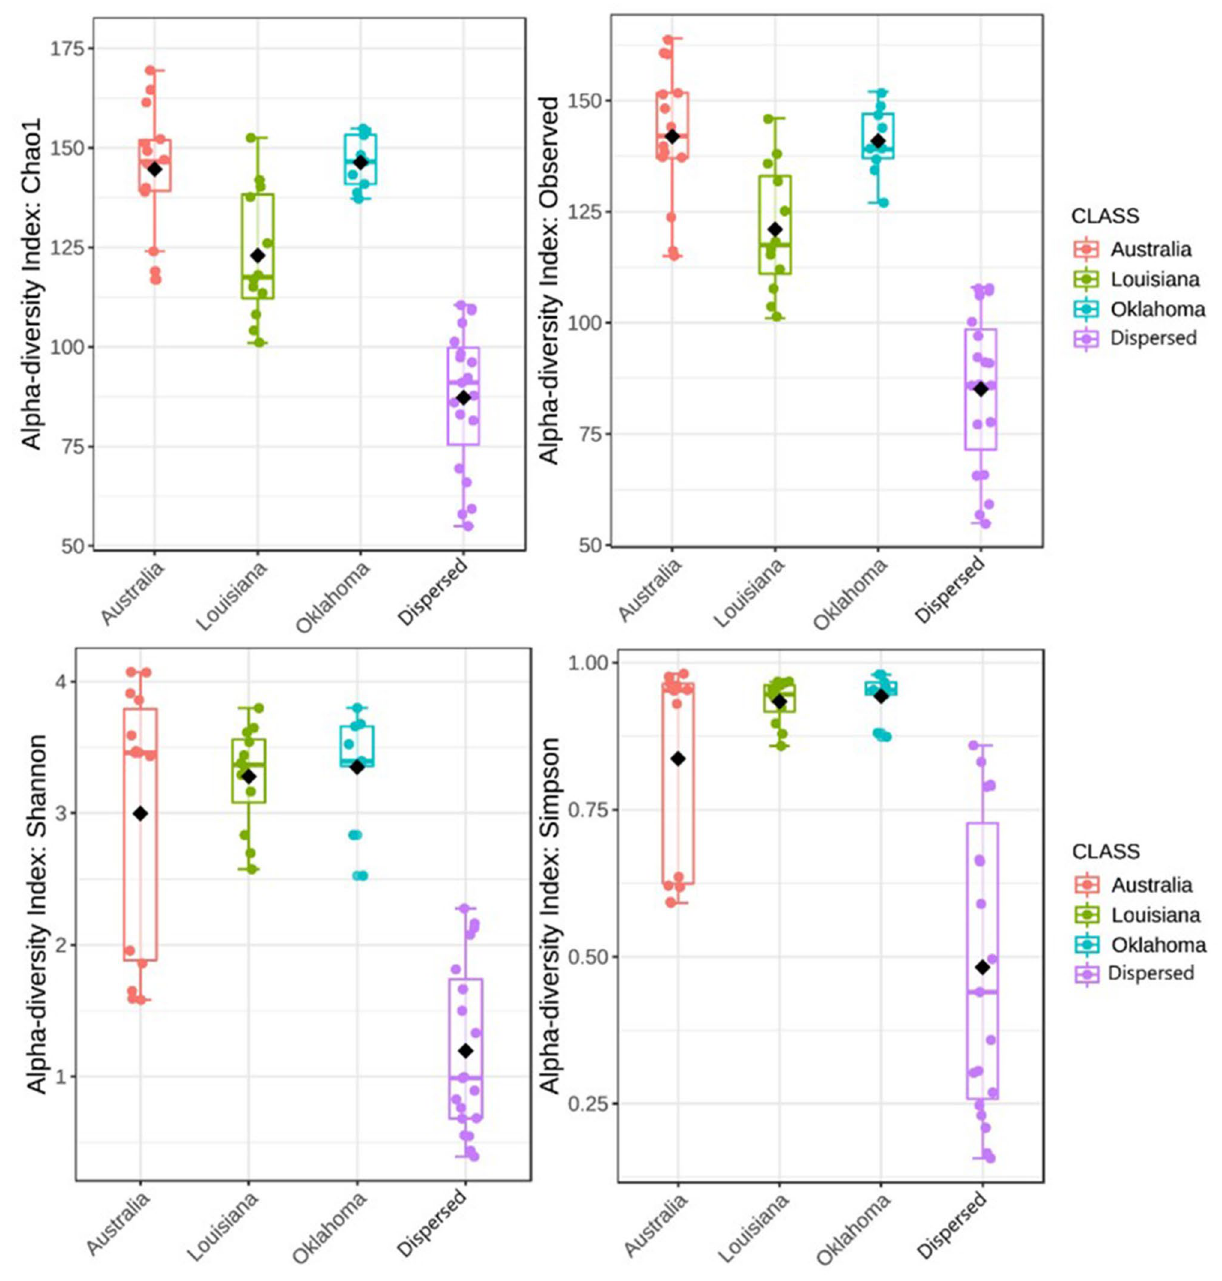
Figure 2. Box plot representing the alpha-diversity values for microbial communities recovered from endometrial lavage samples of healthy mares. The samples are grouped, and color coded according to their geographical origin (i.e., Oklahoma, Louisiana, Australia and Dispersed). Chao and Observed ASV metrices measure species richness while Shannon and Simpson indices measure evenness. ANOVA (Chao1 and Observed ASVs) and Kruskal–Wallis tests (Shannon and Simpson) were utilized to conduct between group Simpson indices 20 . All four alpha diversity measures indicated that the uterine microbiomes of mares from four different geographical regions were significantly different in species richness and evenness (p < 0.05) (Fig. 2, Table 1). Australian samples were the highest in species richness, while Oklahoma samples were leading in spe- cies evenness. To further ascertain the source of this intergroup difference in alpha diversity, pair-wise comparisons were conducted using Tukeys HSD and Dunn Test with B–H correction 21 on species richness and evenness metrices respectively (Table 2). The pair-wise comparisons between the Dispersed group and all other groups were sig- nificantly different (p-adj < 0.05) in both species’ richness and evenness. Pairwise comparisons between Okla- homa and Australia deemed not significant for both species richness and evenness (p-adj > 0.05), while both